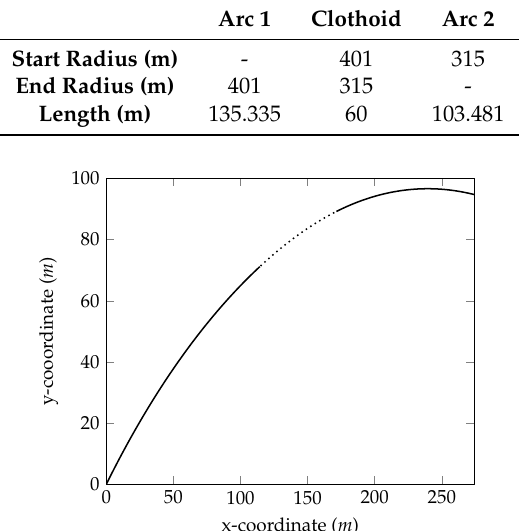
Figure 3. Layout of the original railway curve. Two circular arc segments (solid) connected by a clothoid segment (dotted).